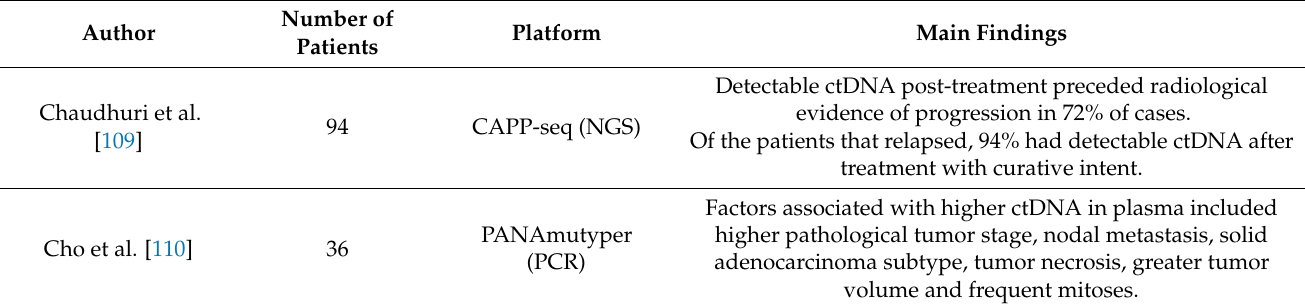
Table 2. Summary of published studies assessing the role of ctDNA in lung